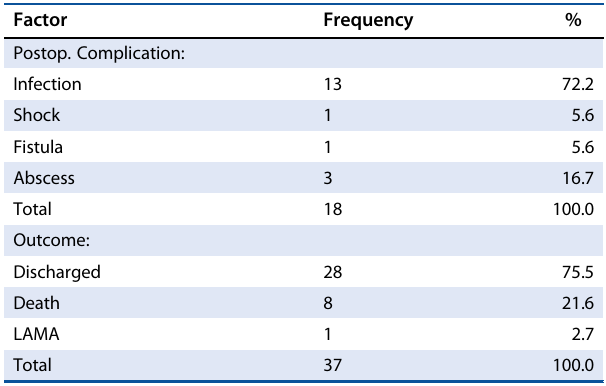
LAMA Total LAMA=left against medical advice.